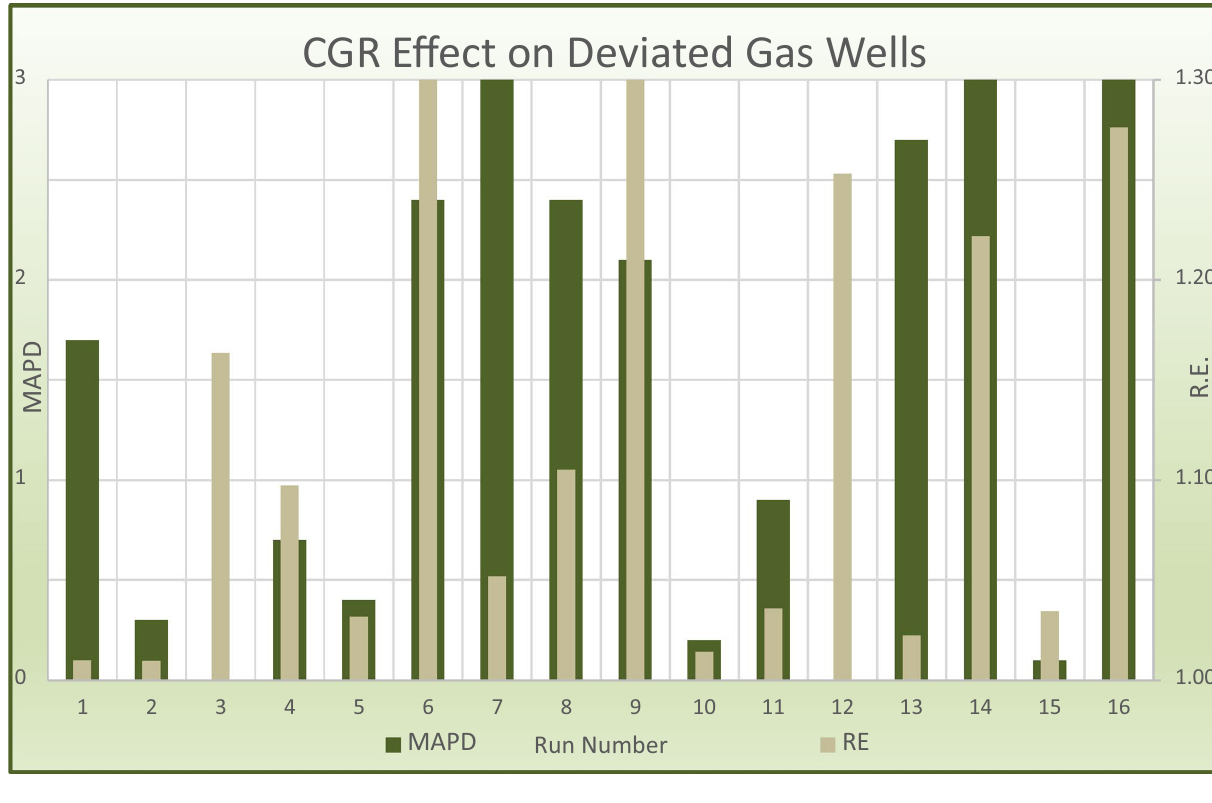
Fig. 2 Effect of CGR on deviated wells using MAPD and RE